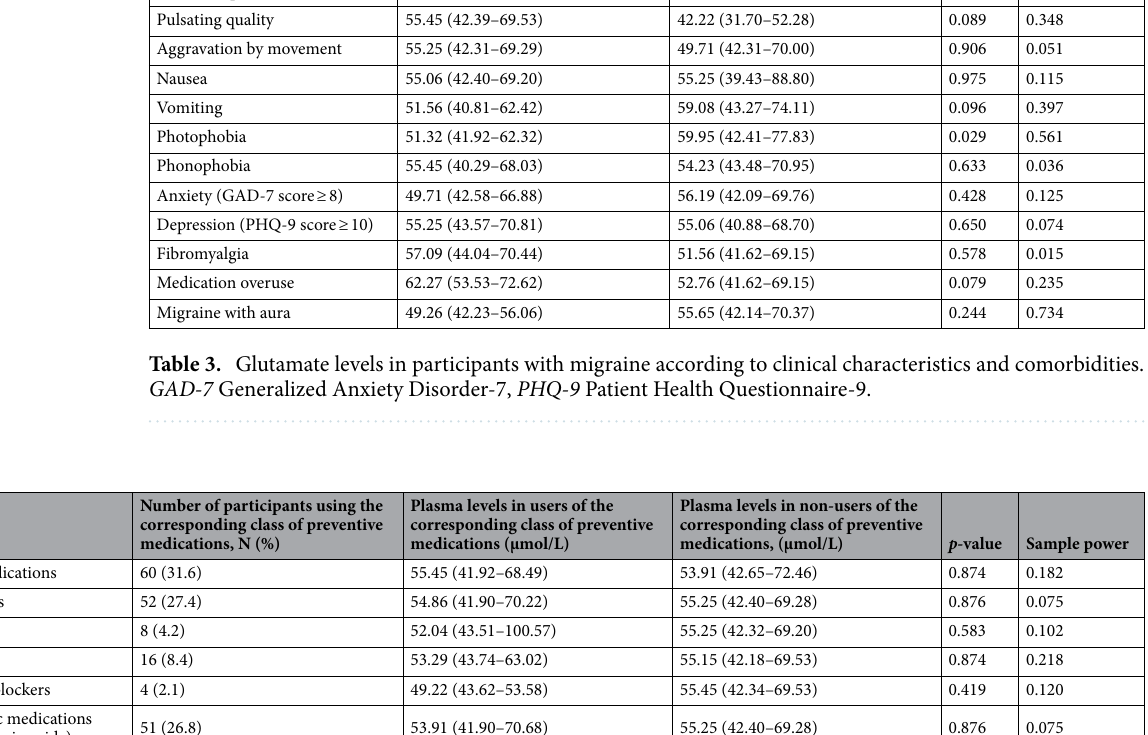
Table 4. Glutamate levels according to the classes of preventive medications.